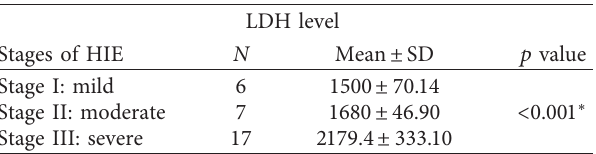
Table 5: LDH levels according to the stages of hypoxic ischemic